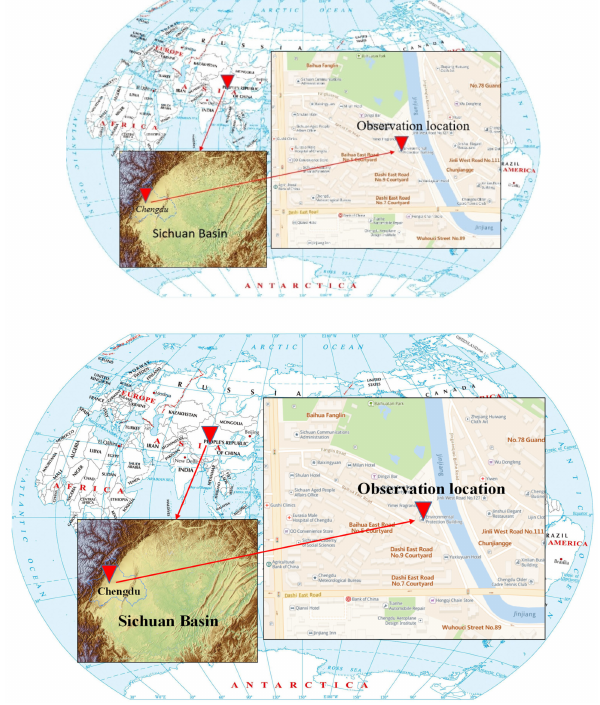
Figure 1. Schematic diagram of the observation